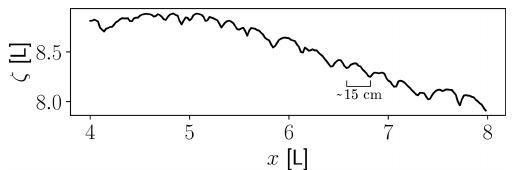
Figure 11. Profile of a section of the natural hillslope highlighting relatively uniform rill